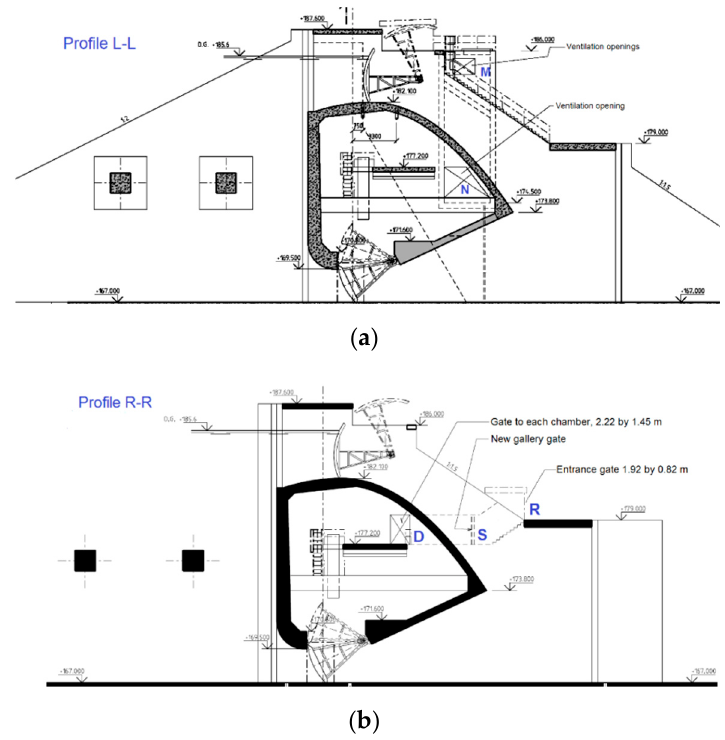
Figure 3. Longitudinal profile through the centerline of each outlet: ( a ) along the left outlet; ( b ) along the right outlet. Opening D is at the end of the gallery.